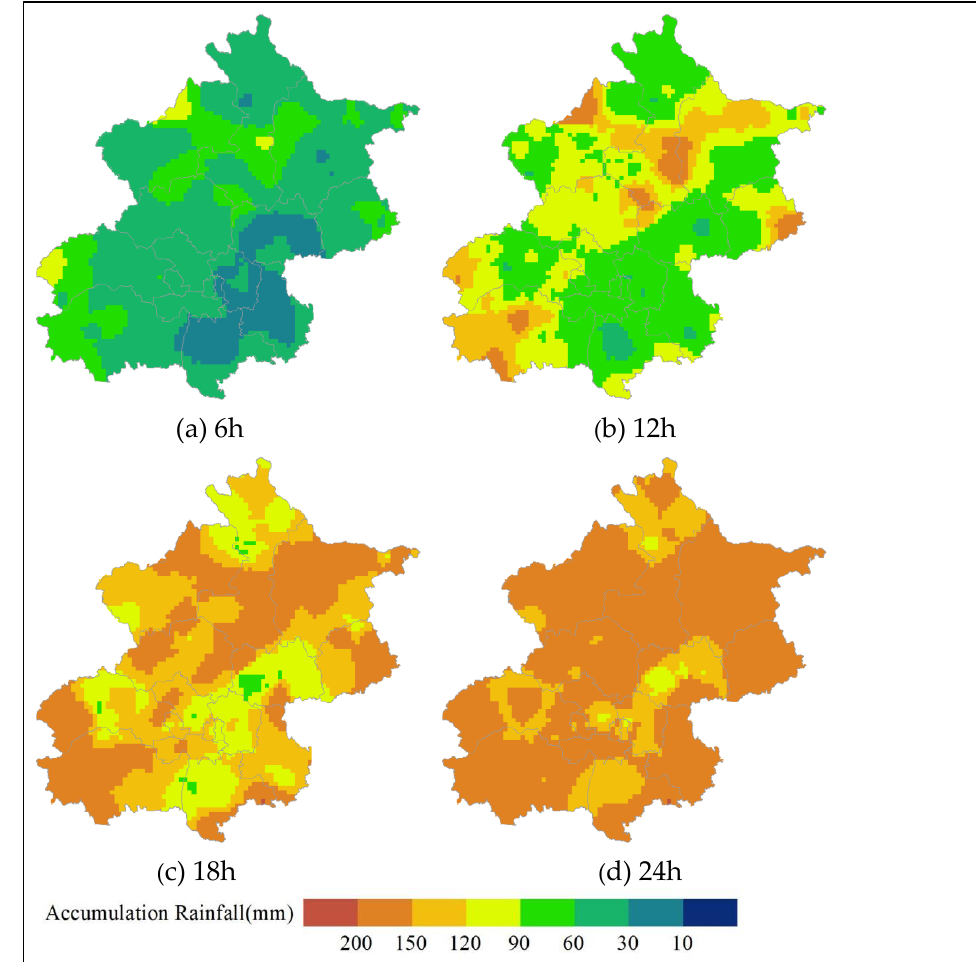
Figure 4. Temporal and spatial distribution pattern of 24 h rainfall in Beijing.